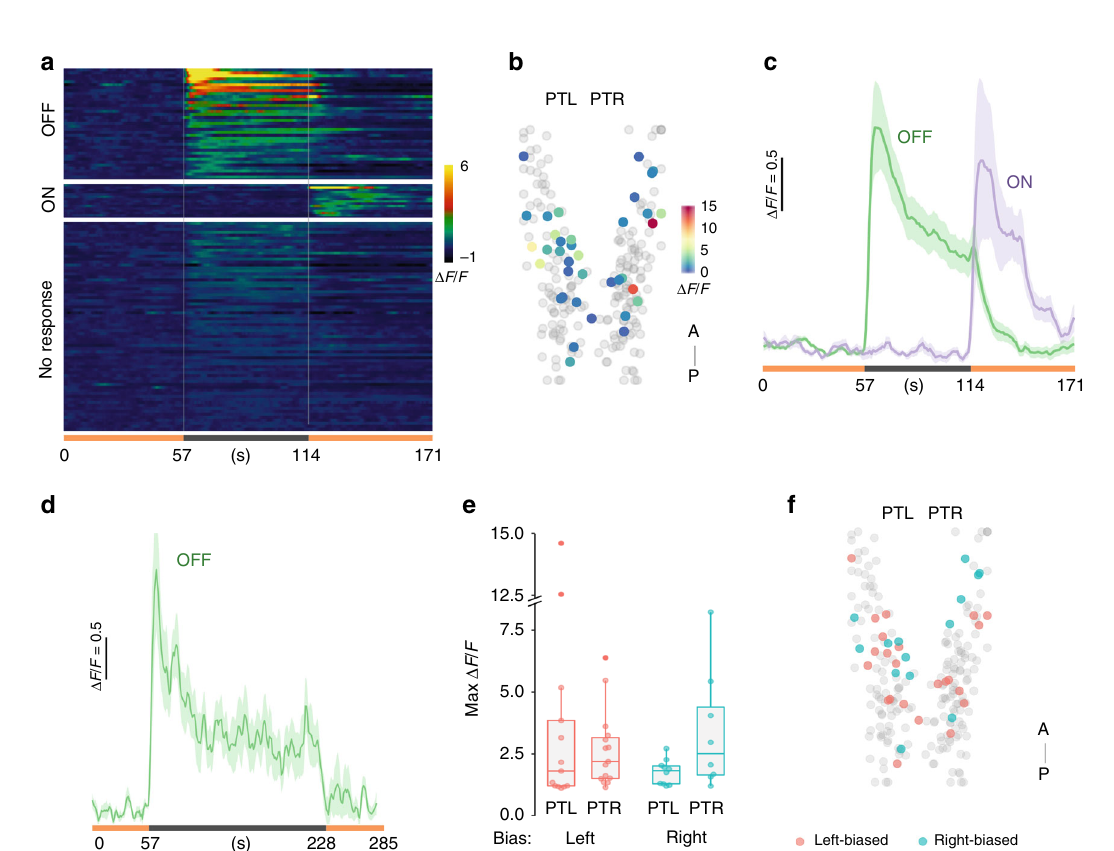
Fig. 3 Neurons in the posterior tuberculum maintain left/right identity. a Chemogenetic ablation screen: transgenic lines with restricted Gal4 patterns were crossed to a UAS:epNTR-RFP reporter. Both epNTR-RFP + and non- fl uorescent siblings (as controls) were treated with metronidazole before testing for motor asymmetry under light and dark conditions. b Match index for drug-treated controls ( y279 N = 53; y375 N = 43; otpbA N = 35) and following genetic ablation ( y279 N = 57; y375 N = 37; otpbA N = 46) during paired baseline (yellow) and dark (gray) responses. Asterisk p < 0.05, r = 0.31, 0.49, 0.3, and 0.34, respectively (left to right); # p < 0.05, r = 0.25, Mann – Whitney U test. c , d Whole-brain dorsal Zebra fi sh Brain Browser (ZBB) projections for y279 ( c ) and y375 ( d ). Color is depth scale. e Computed intersect y279 and y375 expression patterns. Arrowhead indicates a cluster in the rostral PT. f Dorsal confocal projection through the rostral PT in (top) y279-Gal4, UAS:Kaede (green) crossed to vglut2a:dsRed (red) or (bottom) y279-Gal4, UAS:Kaede (green) crossed to gad1b:dsRed (red). Scale bar 20 µ m. g Match index in unablated controls ( N = 45) and after bilateral laser ablation of the PT ( N = 17) and Hc ( N = 19) during baseline (yellow) and on dark trials (gray). Asterisk p < 0.05, r = 0.44 and 0.59, respectively, Mann – Whitney U test. h Net turn angle (mean on trials 1 – 4) for the left PT hemisphere (gray, N = 27) and the right PT hemisphere (cyan, N = 23) ablations. Hc unilateral ablations (right bars) (left hemisphere gray, N = 24; right hemisphere cyan, N = 22). Asterisk p < 0.001, d = 1.3, t test. i Percentage of dark evoked long-latency startle responses initiated in the rightward direction for intact controls ( N = 23), left ( N = 15) or right ( N = 14) hemisphere PT ablation. Asterisk p < 0.001, d = 1.4, t test. Error bars represent standard error of the mean. Box plots show median and quartiles with whiskers indicating 10 – 90%. Source data are provided as a Source Data fi le.